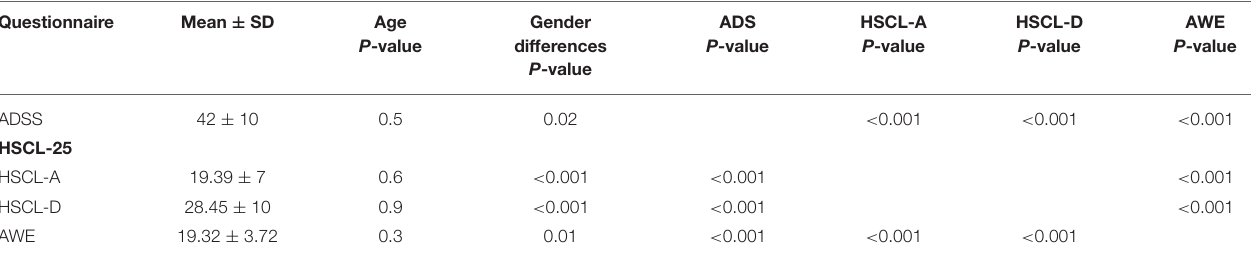
TABLE 2 | The relation between mental health, war experiences and daily stressors with age and gender.